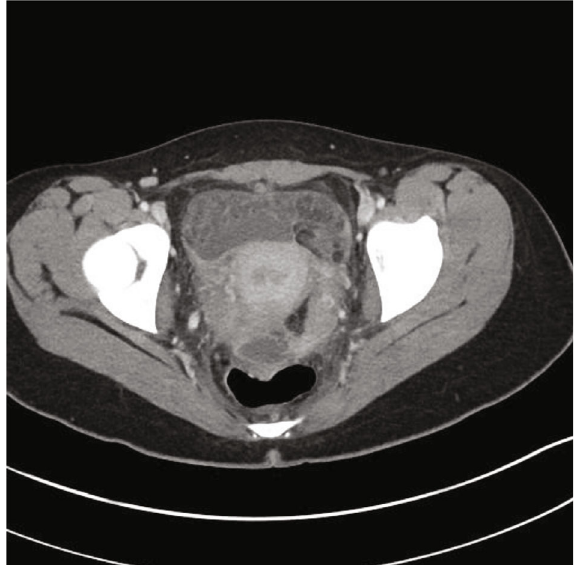
Figure 1: Initial enhanced abdominal CT scan showing free pelvic fl uid.